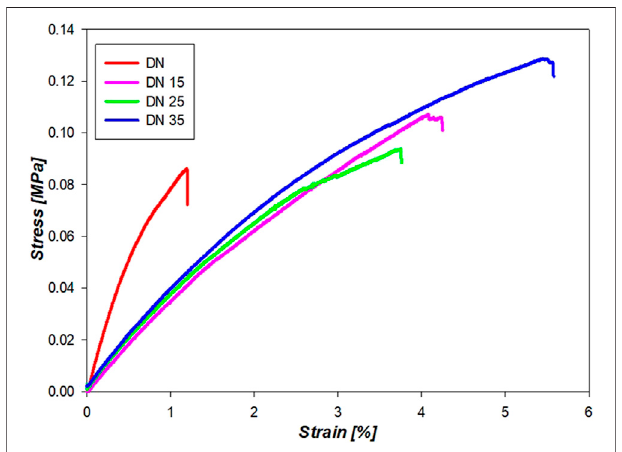
FIGURE 11 | Young ’ s modulus of the double network